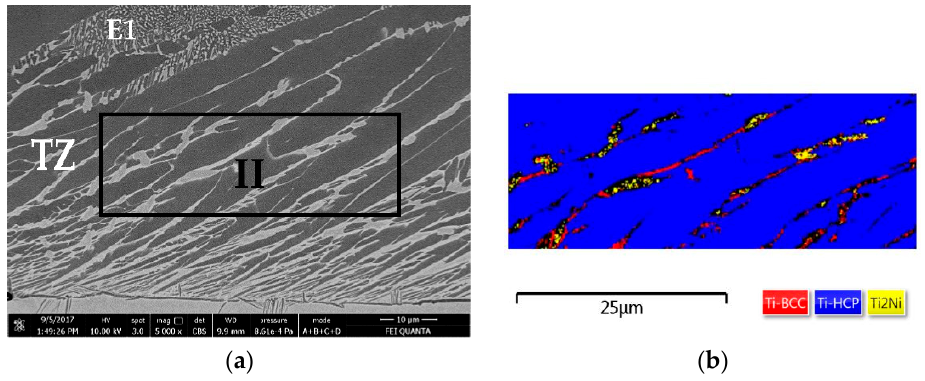
Figure 4. Scanning electron microscope (SEM)/electron back scattered diffraction (EBSD) analysis results of the transition zone (TZ) between the brazed zone (BZ) and CP-Ti substrate brazed at 1000 °C for 600 s: ( a ) SEM/BEI, ( b ) EBSD map of location II in ( a ).